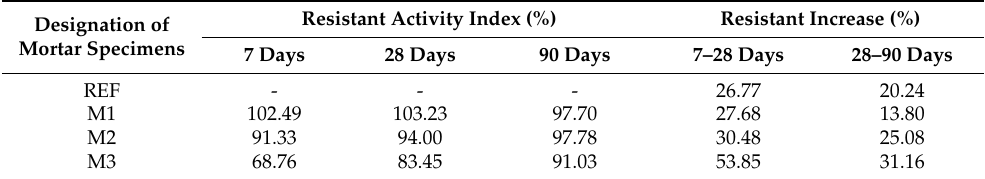
Table 5. Results of Resistance activity index and resistant